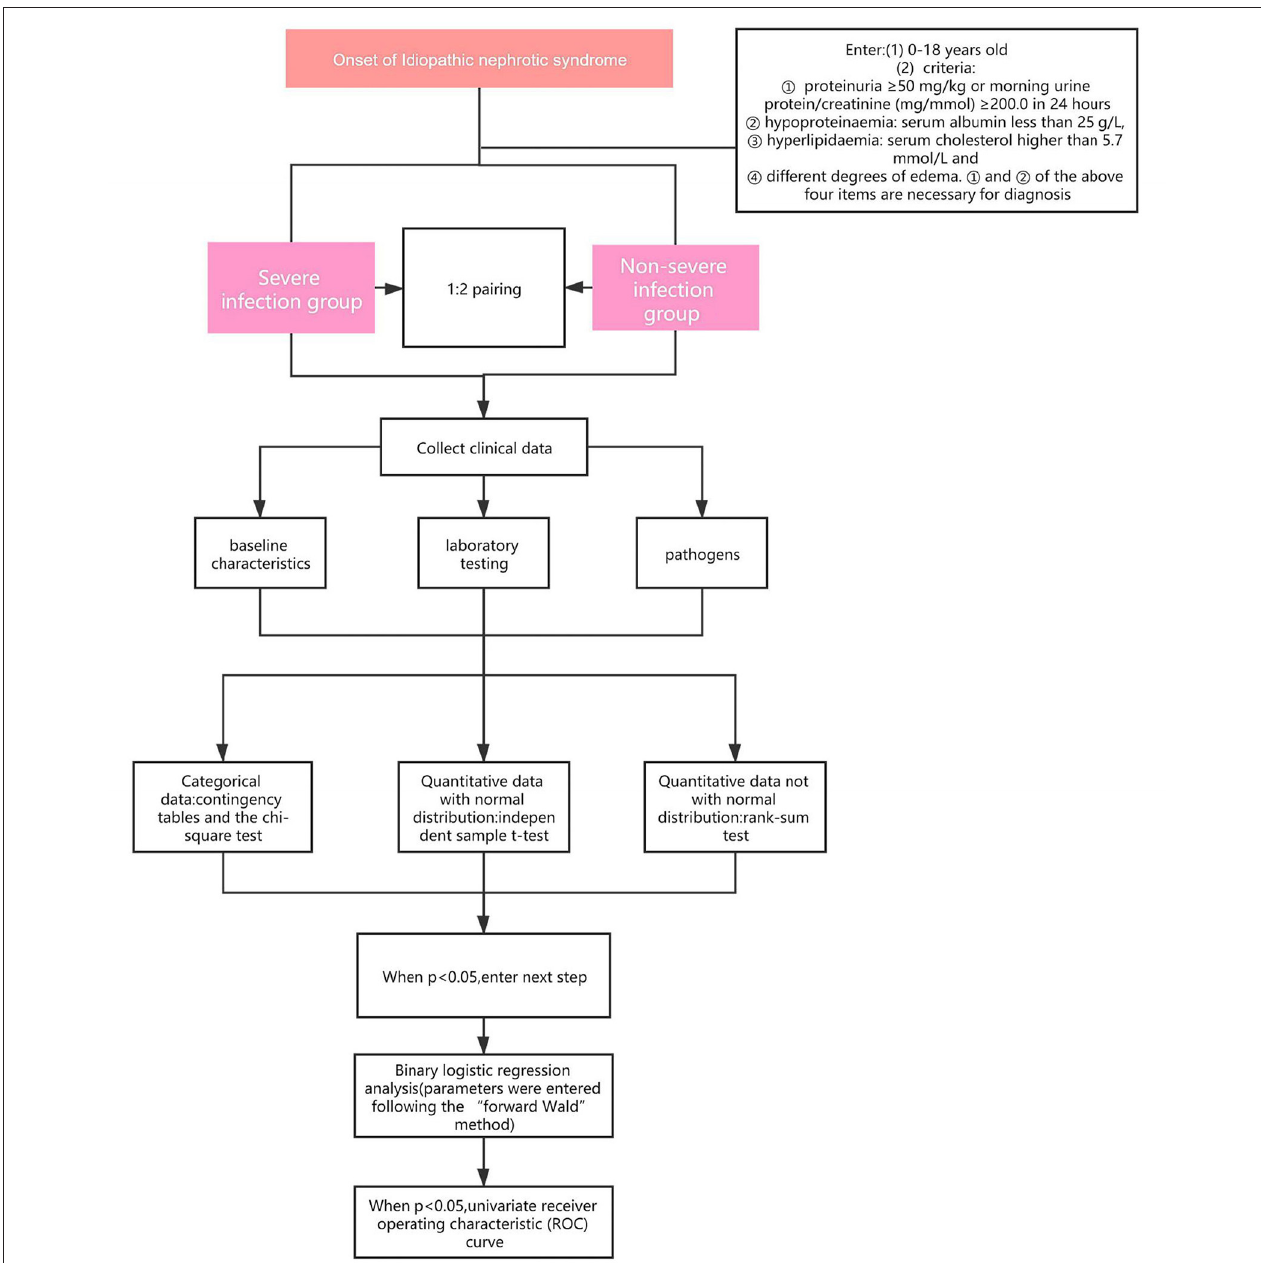
FIGURE 1 | Experimental design